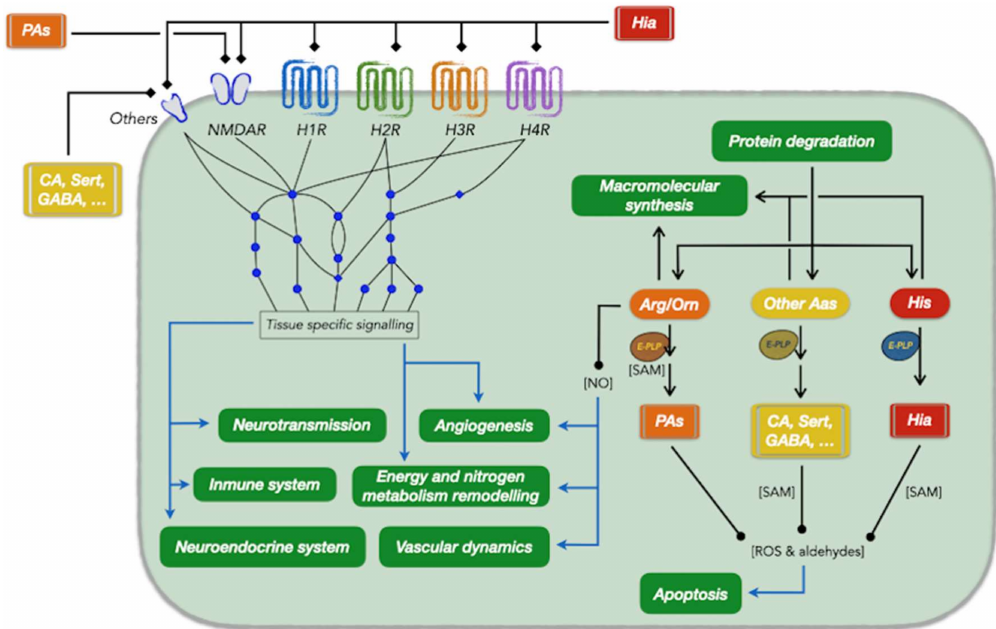
Figure 1. Relationships between histamine and other amines with different physiological and cellular processes. The processes are depicted in green boxes. Abbreviations (by alphabetical order): Aas, amino acids; Arg/Orn, arginine/ornithine; CA, catecholamines; E-PLP, pyridoxal phosphate dependent enzyme; GABA, gamma aminobutyric acid; H1R, histamine receptor 1; H2R, histamine receptor 2; H3R, histamine receptor 3; H4R, histamine receptor 4; Hia, histamine; His, histidine; NMDAR, N-Methyl-D-aspartic acid receptor; NO, nitric oxide; PAs, polyamines; ROS, reactive oxygen species; SAM, S-adenosyl methionine; Sert,